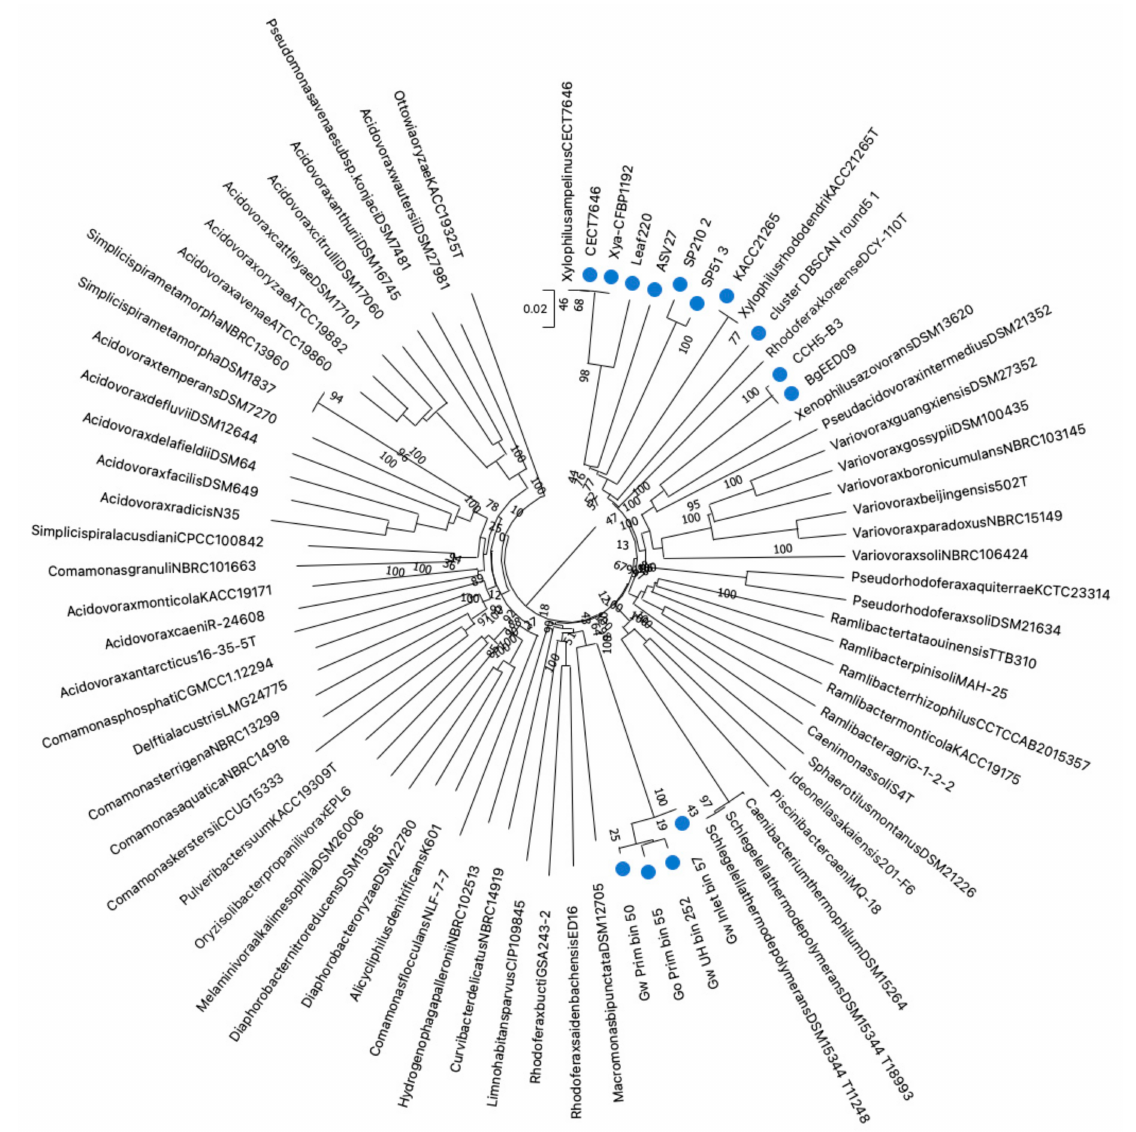
Figure 1. Phylogenetic tree provided after TYGS analysis [30]. Tree inferred with FastME 2.1.6.1 [36] from GBDP distances calculated from genome sequences. The branch lengths are scaled in terms of GBDP distance formula d 5 . The numbers on branches are GBDP pseudo-bootstrap support values > 60% from 100 replications, with an average branch support of 81.2%. The tree was rooted at the midpoint [37]. The Newick file was edited in MEGA11 [32]. The 14 blue dots correspond to the uploaded